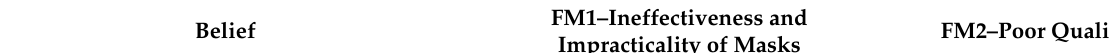
Table 3. Correlation between factors and beliefs about wearing face masks.